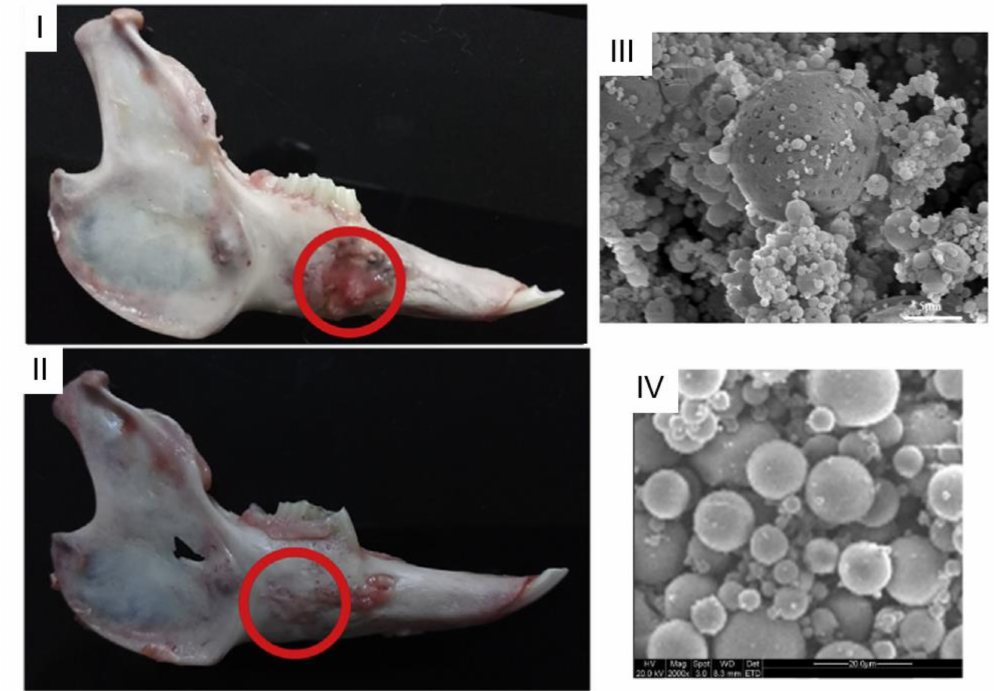
Figure 12. Observation of rabbit mandibles samples 12 weeks after operation ( I ) control group, ( II ) BMP-2/VEGF group, ( III ) SEM images of drug-loaded PLGA particles (scale 5 µ m). (Adapted with permission from [74]. Copyright (2020) Elsevier); ( IV ) PDGF-BB encapsulated alginate microparticles. (Adapted with permission from [76]. Copyright (2019)